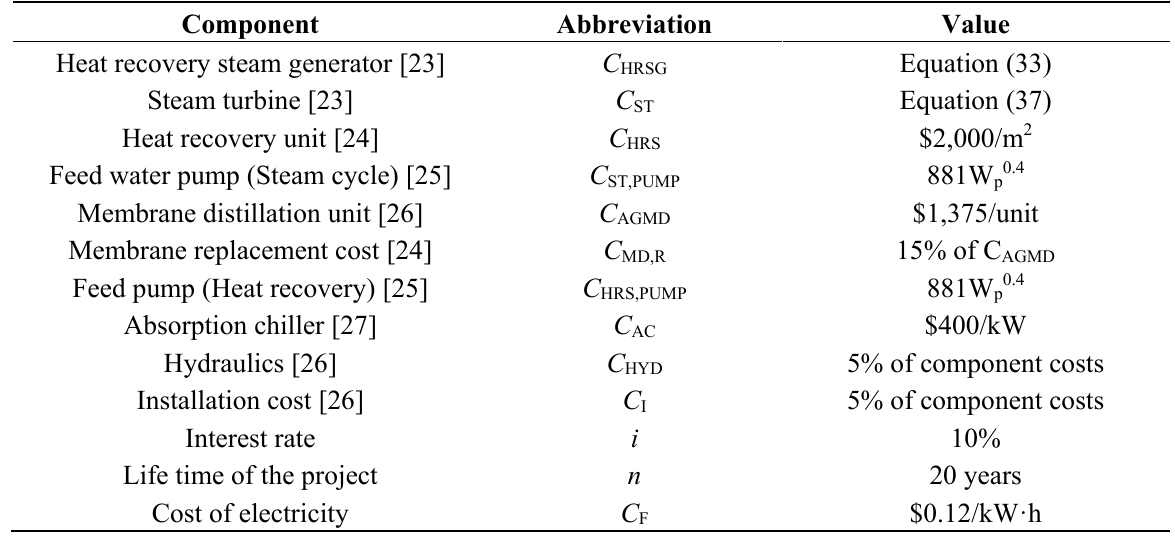
Table 4. Parameter and costs required for economic analysis.